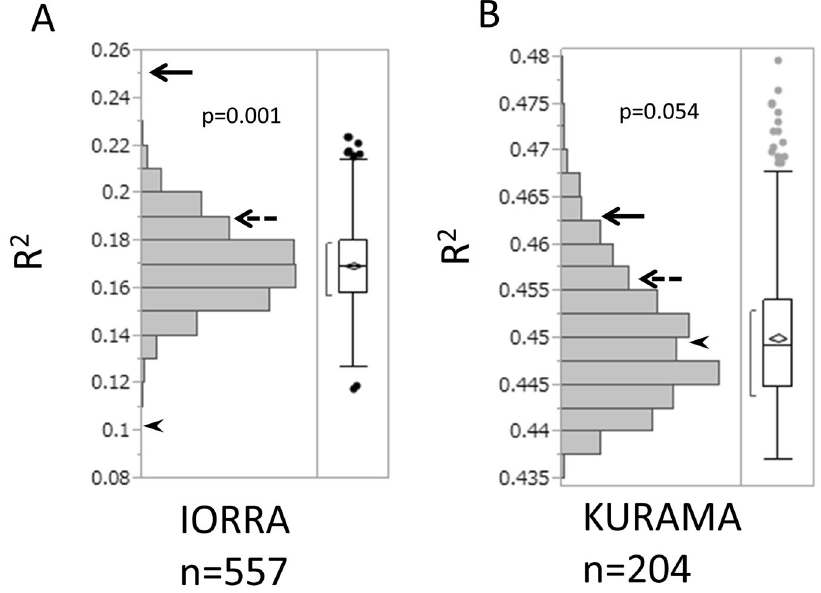
Figure 2. Better fit of time-averaged disease activity on joint destruction than one-time disease activity in the Japanese subjects. Empirical p-values of time-averaged DAS28 are indicated for ( A ) the IORRA and ( B ) KURAMA cohorts. Bar charts indicate distribution of R 2 of the 1000 one-time DAS28. The solid and broken arrows indicate the time-averaged DAS28 and the latest DAS28, respectively. The arrowheads indicate the first DAS28.